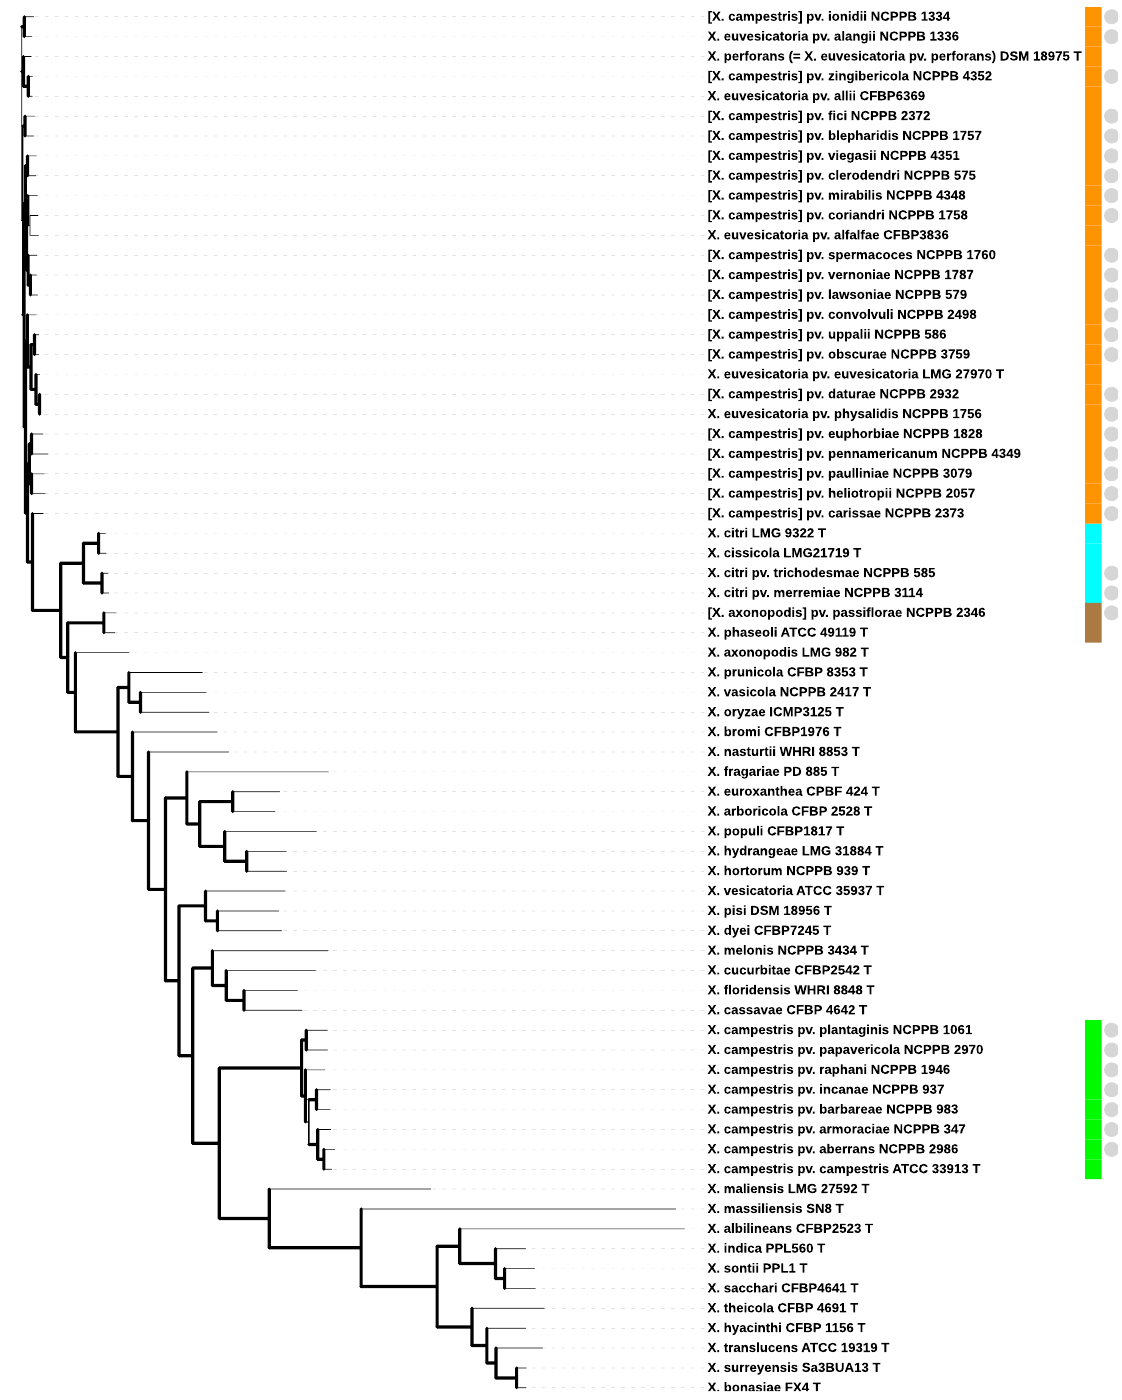
Figure 1. Phylogenetic tree, based on core genome sequences, for the newly sequenced strains, species type strains and relevant pathovar pathotype strains of Xanthomonas , generated using PhaME [50] and FastTree [51]. The tree was graphically rendered using the Interactive Tree of Life [52]. Configuration and tree files are available from https://github.com/davidjstudholme/phylogenomics-Xanthomonas-2 (accessed on 19 November 2022). Grey circles indicate genomes sequenced in the present study. Clades corresponding to X. euvesicatoria , X. citri , X. phaseoli and X. campestris are indicated by strips of orange, cyan, brown and green, respectively. A list of accession numbers and references for the genome sequences is provided in Appendix A as Table A1.